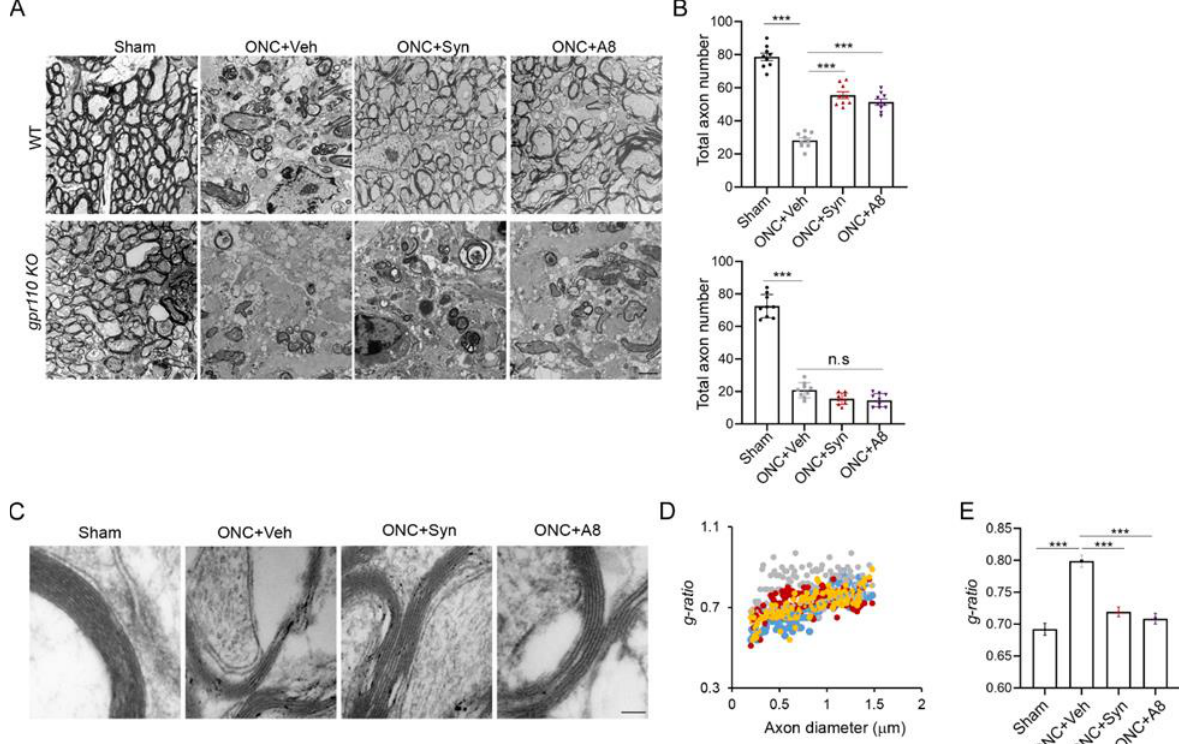
Figure 5. Structural integrity of axons deteriorated by ONC was improved by treatment with GPR110 ligands. ( A , B ) Transmission electron microscopic images show cross sections of the optic nerves from sham and vehicle-, synaptamide- or A8-treated WT or gpr110 KO mice at 12 weeks after ONC ( A ), and the quantitation of the total axon number per field ( B ). Data are expressed as mean ± s.e.m. of the total 9 sections (3 sections per mouse) from 3 mice per group. ( C – E ) Electron microscopic images show the thickness of the myelin sheath of the axon fibers at 12 weeks after ONC ( C ) and the scatter plot for the g-ratio (the ratio of the inner to the outer diameter of the myelin sheath) as a function of axon diameter ( D ), along with the average g-ratio for the sham (blue), ONC + vehicle (grey), ONC + synaptamide (red) and ONC + A8 (orange) groups ( E ). Data are expressed as mean ± s.e.m. of the total 114 axons from 6 mice per group. *** p < 0.001. Scale bars, 2 m ( A ) and 100 nm ( C ). n.s., not significant.